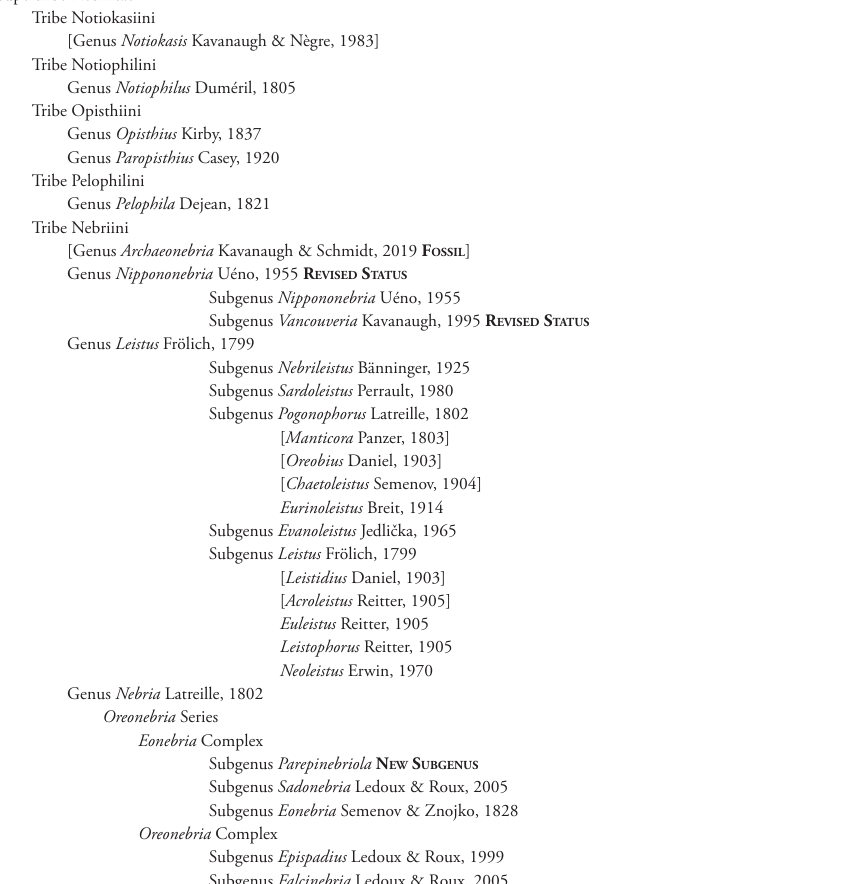
Table 4. A revised classification of the supertribe Nebriitae. Supertribe Nebriitae Tribe Notiokasiini [Genus Notiokasis Kavanaugh & Nègre, 1983] Tribe Notiophilini Genus Notiophilus Duméril, 1805 Tribe Opisthiini Genus Opisthius Kirby, 1837 Genus Paropisthius Casey, 1920 Tribe Pelophilini Genus Pelophila Dejean,